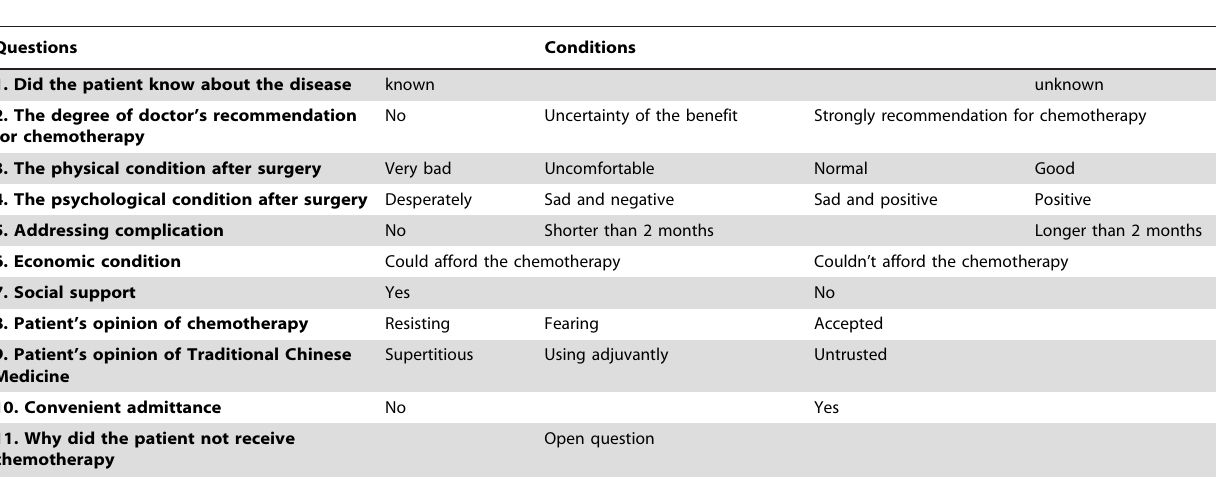
Table 2. Elderly Cancer Patients’ Chemo-Refusing Reason Questionnaire